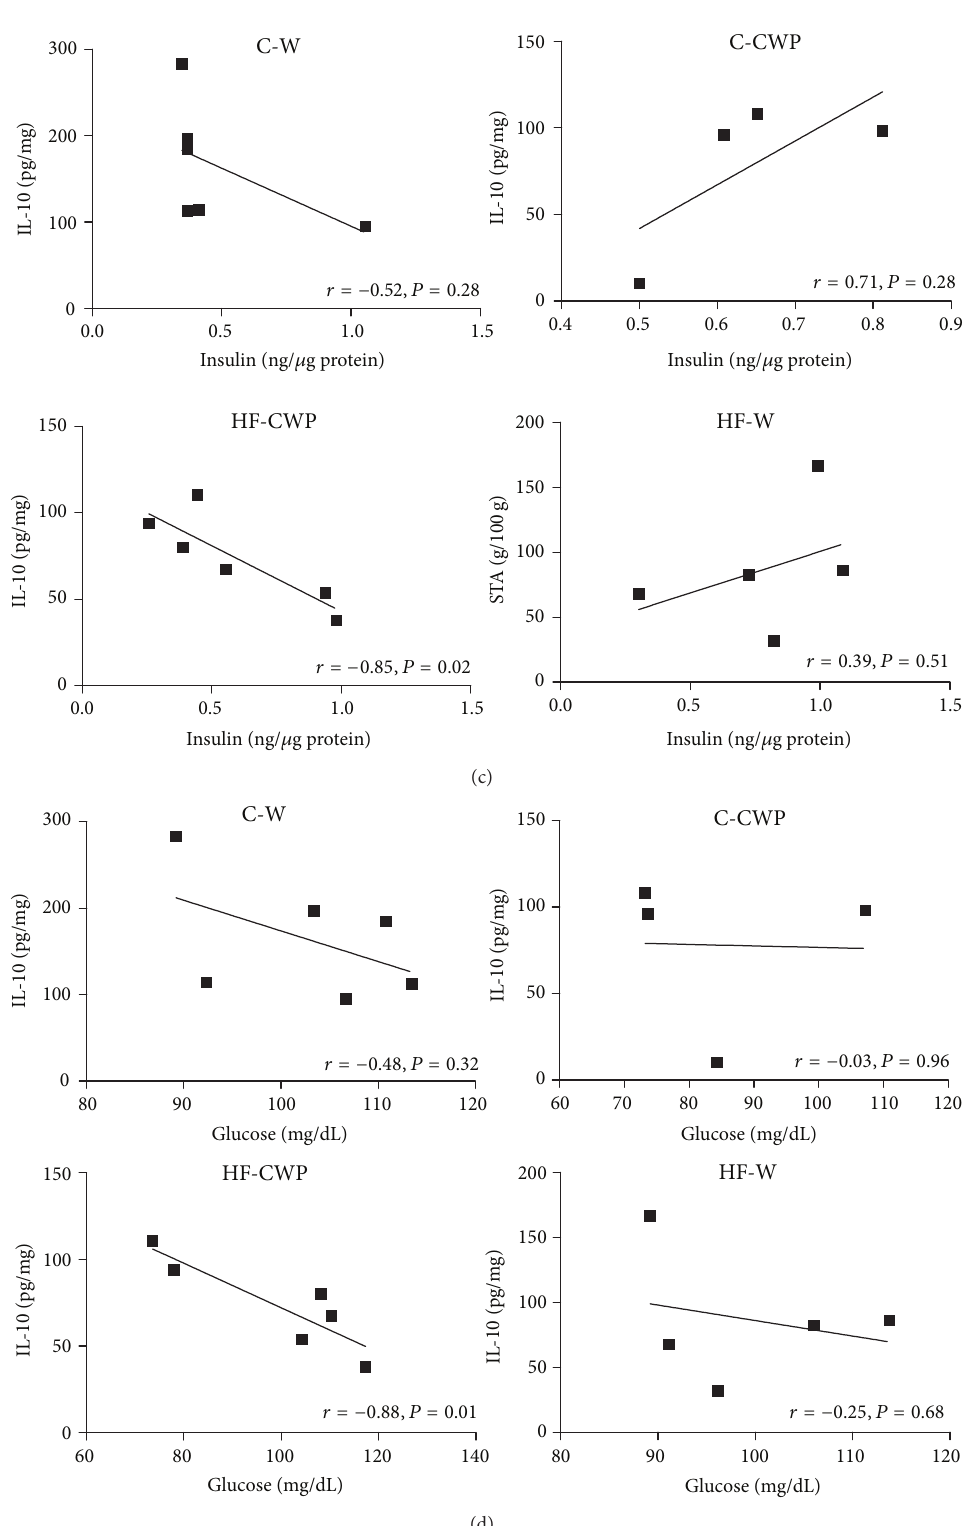
Figure 5: Correlation between different experimental groups: (a) TAG and AUC in different experimental groups. (b) Insulin and STA (sum of adipose tissues MES, RET, and EPI). (c) Insulin and IL-10 of serum and mesenteric adipose tissue, respectively, and (d) glucose and IL-10 of serum and mesenteric adipose tissue,